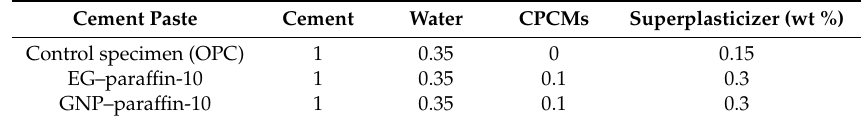
Table 2. Mix proportion (mass ratio) of composite phase change materials (CPCM) in cement